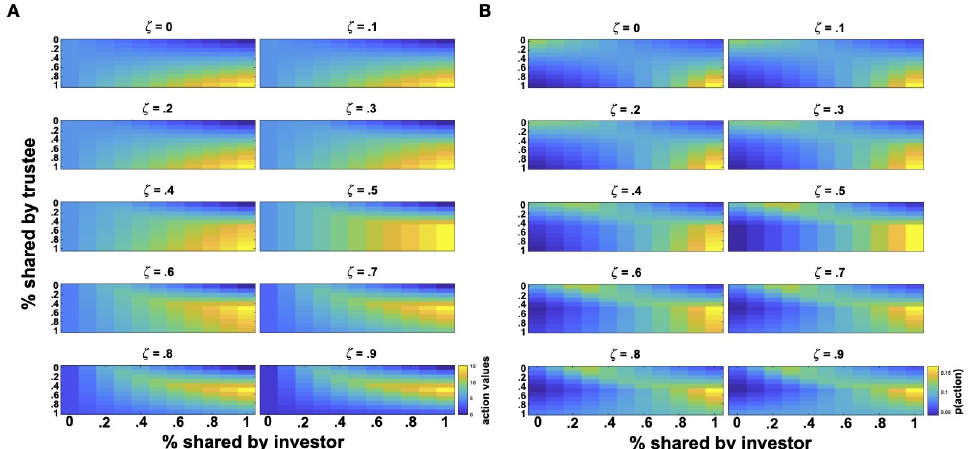
Figure 2. Action values and probabilities with varying ζ . Action values ( A ) and action probabilities ( B ) for investors with different ζ parameters (i.e., guilt or advantageous inequality) as computed according to the inequity aversion model. In all plots, ι is set to 0. For action probability estimation, the χ parameter of investors’ policy is set to